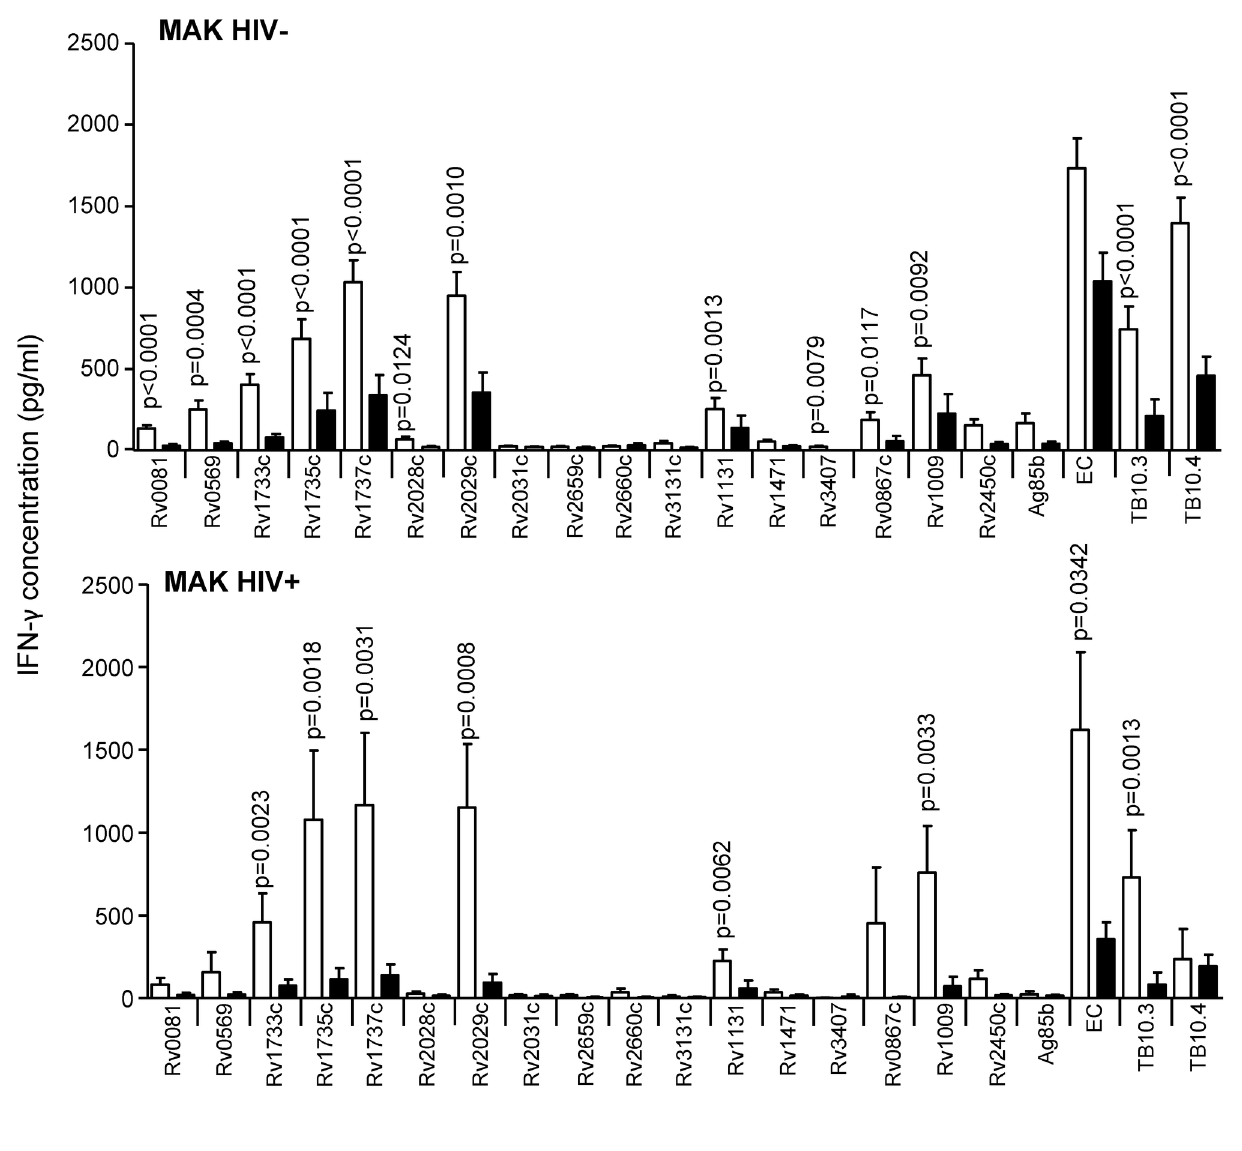
Figure 5. IFN-γ secretion in response to secreted, latent, and reactivation Mtb antigens in active TB and LTBI subjects, from Uganda. IFN-γ ELISA was performed on supernatants collected after 7-day antigen stimulation of diluted blood from TB cases (black) and TST + (LTBI) controls (white) from MAK (Uganda). Line indicates median, whiskers indicate 5–95% range and dots indicate outliers. Data were analysed by Mann-Whitney U-test for HIV – and/or HIV + subjects. Significant differences are indicated.